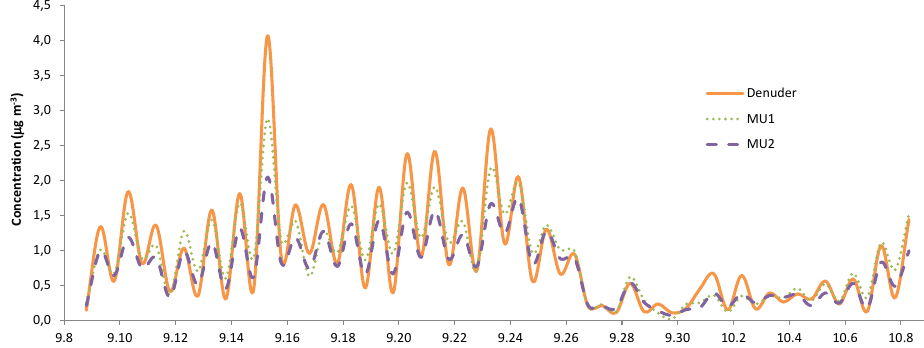
Fig. 11. Denuder and MUs measured HNO 3 concentrations during the ETV period. 2 Figure 11. Denuder and MU measured HNO 3 concentrations during the ETV period.